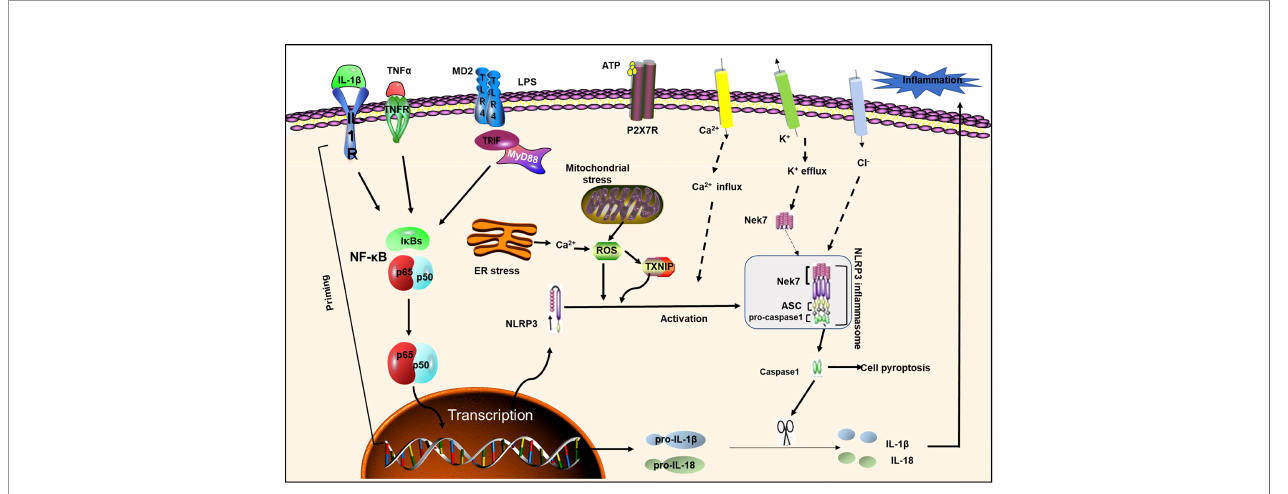
FIGURE 1 | NLRP3 in fl ammasome priming and activation. NLRP3 in fl ammasome activation requires two signals: Signal 1 (initiation) is provided by activating cytokines or PAMPs, resulting in transcriptional upregulation of normative and non-standard NLRP3 in fl ammasome components. Signal 2 (activation) is activated by K + ef fl ux, Ca 2+ in fl ux, and mitochondrial reactive oxygen species, etc. ASC; IL-1R1, IL-1 receptor type1; NEK7, NIMA-related kinase7; NF- k B, nuclear factor- k B; P2X7, P2X purinoceptor7; ROS, reactive oxygen species; TLR, toll-like receptor; TNF a , tumor necrosis factor a ; TNFR, tumor necrosis factor receptor;TXNIP, thioredoxin-interacting protein; MD2, myeloid differentiation factor 2;LPS, lipopolysaccharide; ER Stress, endoplasmic reticulum; TIRF, toll-interleukin 1 receptor (TIR) -inducing interferon; MyD88, myeloid differentiation primary response gene